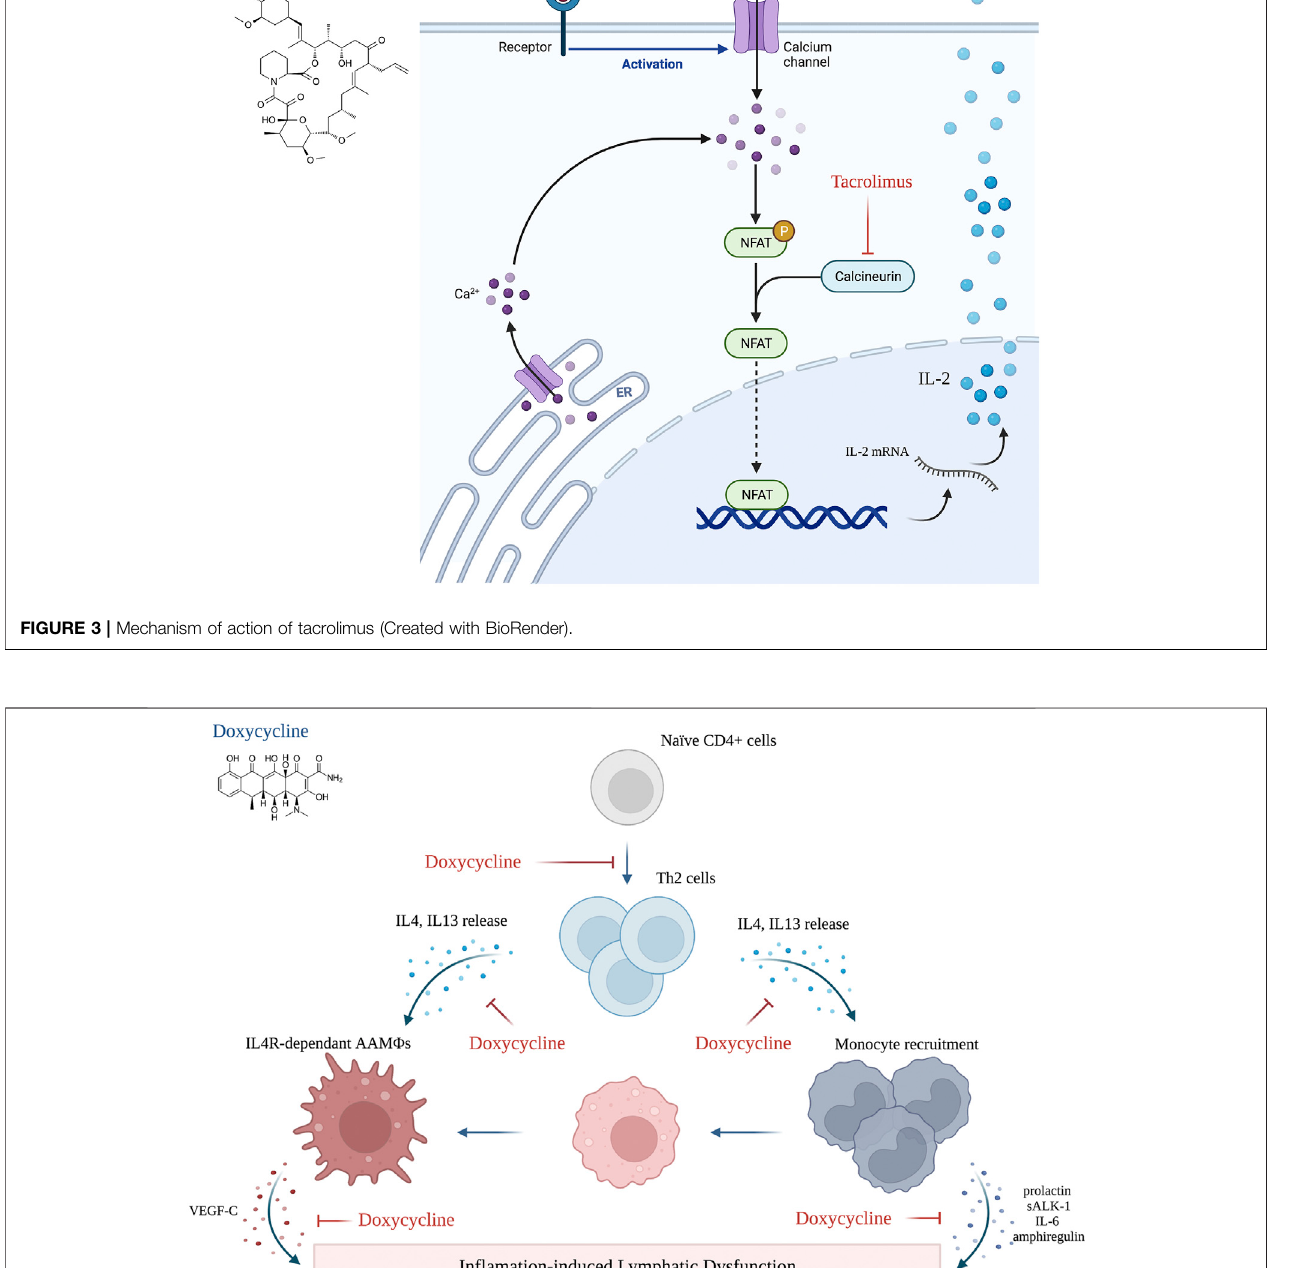
Frontiers in Pharmacology |